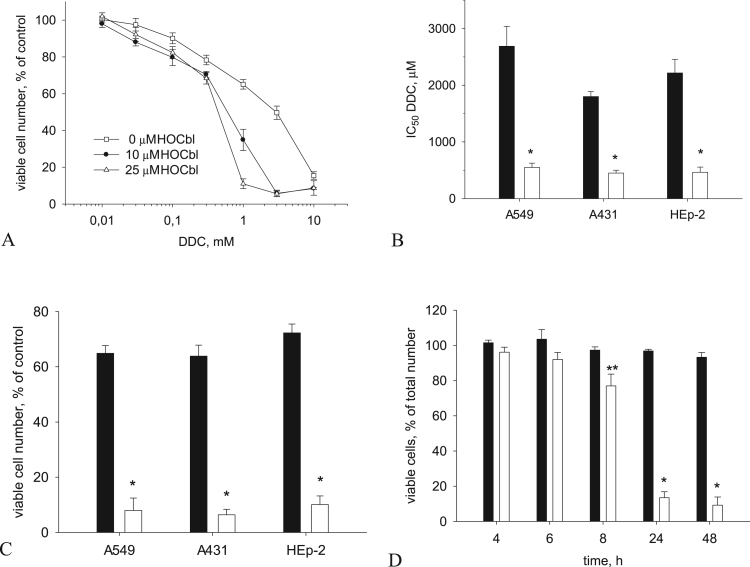
Enhancement of the cytotoxic effect of DDC by HOCbl. (А). Effect of the concentration of HOCbl and DDС on the viability of А549 cells. (B). A decrease in the IC50 value for DDC in combination with 25 μM HOCbl in НЕр–2, А431 and А549 cells. (С). Cytotoxic effect of 48-h incubation of НЕр–2, А431, and А 549 cells with DDC + HOCbl. (D). The time course of the death of А549 cells in the presence of DDC + HOCbl. The components (25 μM HOCbl and 1 mM DDC) were added simultaneously 24 h after the seeding of cells. The action of DDC + HOCbl was interrupted by replacing the culture medium with a fresh growth medium. The cytotoxicity was estimated at 48 h after the addition of the components (see Materials and methods). The data are the means ± SEM of five separate experiments. Dark columns denote 1 mM DDC, and light columns denote DDC + HOCbl. *P < 0.01, **P < 0.05 compared to cells treated with 1 mM DDC.